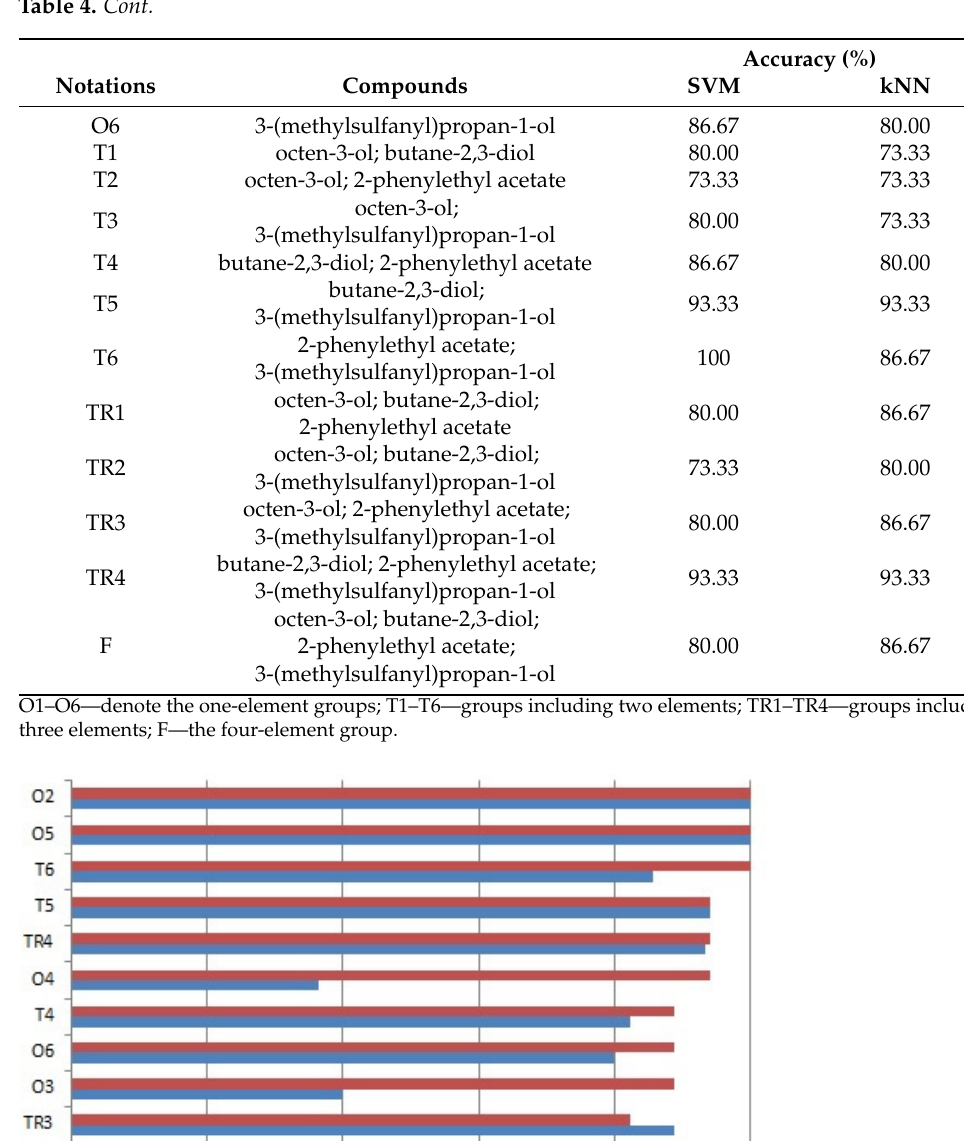
Table 4. Subsets formed from selected compounds.